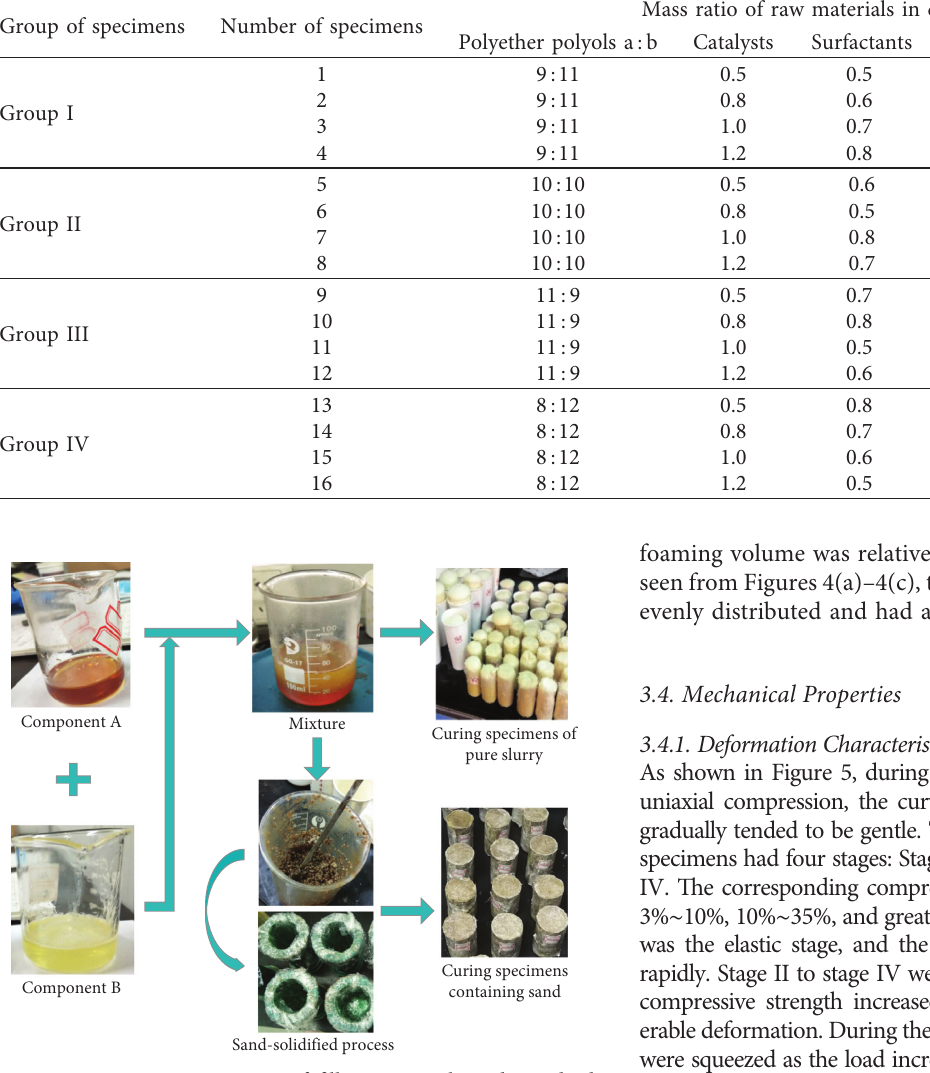
Figure 1: Preparation process of filling materials and standard